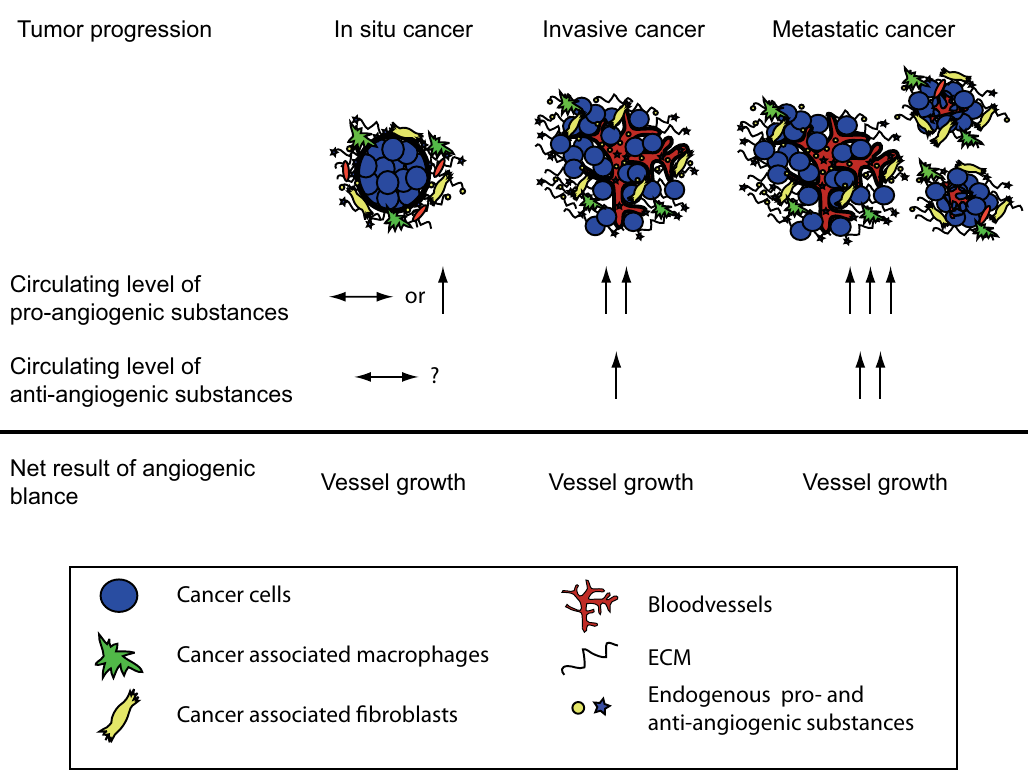
Figure 1. The angiogenic balance and the effect of tumor load. During tumor progression the total concentration of pro-angiogenic molecules is higher than that of anti-angiogenic molecules. This allows for new vessel development and further tumor growth. Note that the total level of the anti-angiogenic factors can be higher in a cancer patient when compared to a healthy individual. However, the pro-angiogenic stimuli are even higher and therefore the increased level of the anti-angiogenic molecules is a reflection of the tumor